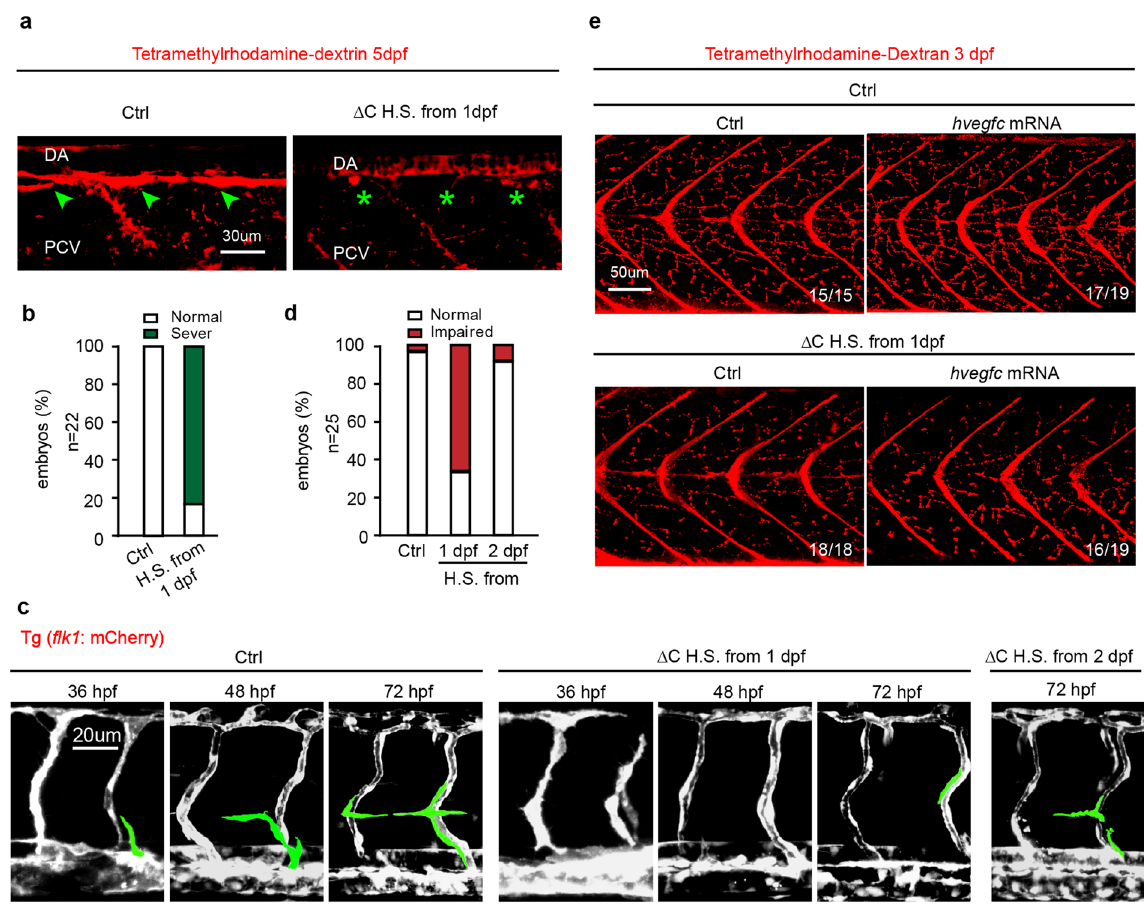
Figure 7. CD146 is essential for lymphangiogenesis independent of angiogenesis. ( a , b ) Tg ( fli1a : EGFP) embryos injected with plasmid of CD146 ∆ C-GFP or its empty control, which was induced to express CD146 ∆ C-GFP by 37 °C heat-shocking for 30 min. The embryos were harvested at 5 dpf. Tetramethylrhodamine- dextran was used to visualize normal TD (green arrow) and abnormal TD (green stars). The criterion used to classify the TD formation in ( b ) was the same as that used in Fig. 4d. Scale bars: 30 μ m. ( c , d ) Tg ( flk1 : mcherry) embryos were treated as same as in ( a ). The embryos were harvested at 36 hpf, 48 hpf and 72 hpf, respectively. Vasculature of blood and lymphatic vessels were observed by confocal microscopy. Images were flanked by redrawing of the vessel contours. Transient lymphangiogenic structures (lymphangionenic sprouts; PL cells) were labeled light green and the other vessels (PCV, DA and ISV) were labeled dark grey. Scale bars: 20 μ m. ( e ) Tg ( fli1a : EGFP) embryos were injected with plasmid of CD146 ∆ C-GFP or its control plasmid together with control or human vegfc mRNA and were heat-shocked to express CD146 ∆ C-GFP at 37 °C for 30 min. Late- phase microangiography was used to visualize typical phenotype of lymphatic capillaries in embryos at 3 dpf. The typical ratio was showed in each panel. Scale bars: 50 μ